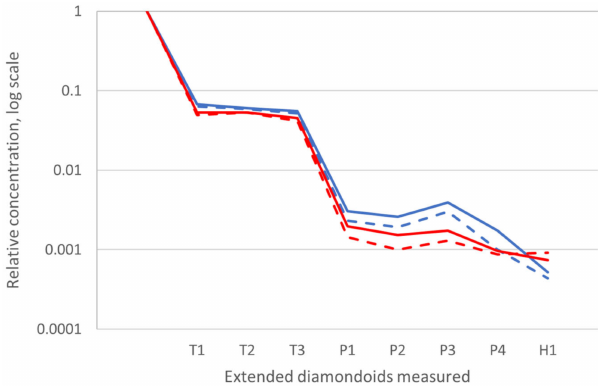
Figure 10. QEDA fingerprints corresponding to TJ-1323 (in red color) and R-706 (in blue color) oils (indicated by continuous lines), and respective hydrous pyrolysates originating from asphaltenic fraction (dash lines). Note: quantities of higher diamondoids are relative to that of triamantane, which is set at one